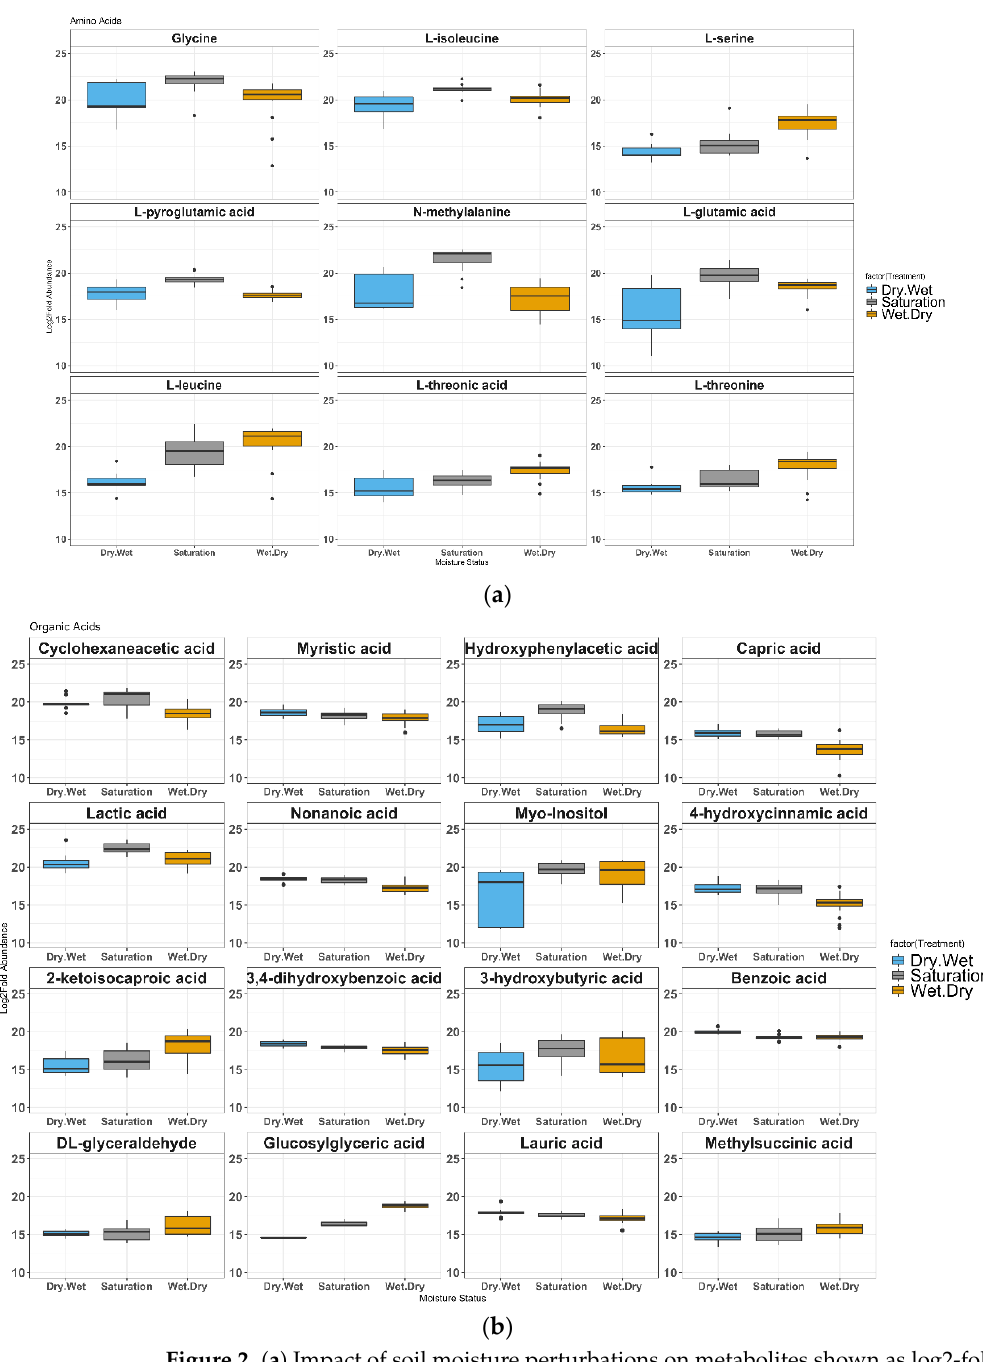
Figure 2. ( a ) Impact of soil moisture perturbations on metabolites shown as log2-fold abundances of amino acid that shifted significantly in response to a moisture treatment (Dry-Wet, Saturation, or Wet-Dry). Nine amino acids changed significantly under the wet or dry treatments compared to control ( p < 0.05, one-way ANOVA). Whiskers indicate the most extreme values within 1.5 multiplied by the interquartile region. Box, 25% quartile; median, 75% quartile. Pairwise comparisons of means to test treatment effects were performed after outlier removal. ( b ) Impact of soil moisture perturbations on the soil metabolome shown as log2-fold abundances of metabolites (other than amino acids) that shifted significantly in response to a moisture treatment (Dry-Wet, Saturation, or Wet-Dry). Fifteen of 70 detected metabolites changed significantly under the wet or dry treatments compared to control ( p < 0.05, one-way ANOVA). Whiskers indicate the most extreme values within 1.5 multiplied by the interquartile region. Box, 25% quartile; median, 75% quartile. Pairwise comparisons of means to test treatment effects were performed after outlier removal.